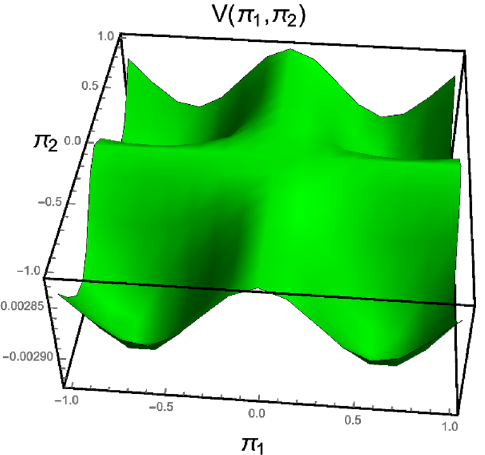
Figure 2. One loop potential for the pions in arbitrary units with m = 0, y = 0 : 5, f = 1 and (cid:21) = 1 ; (cid:22) = 1.